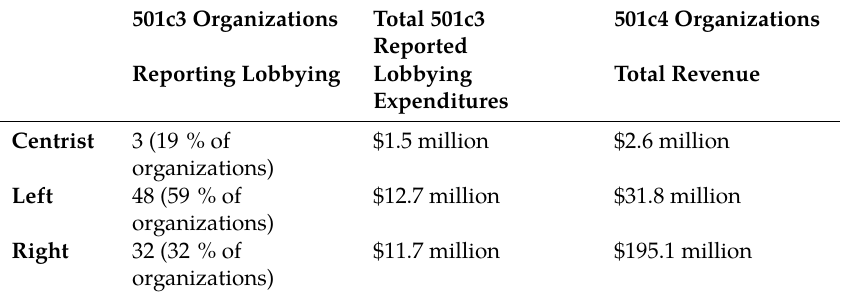
Table 8: Advocacy activity by 501(c)(3) think tanks and 501(c)(4) advocacy organizations in 2016, by political